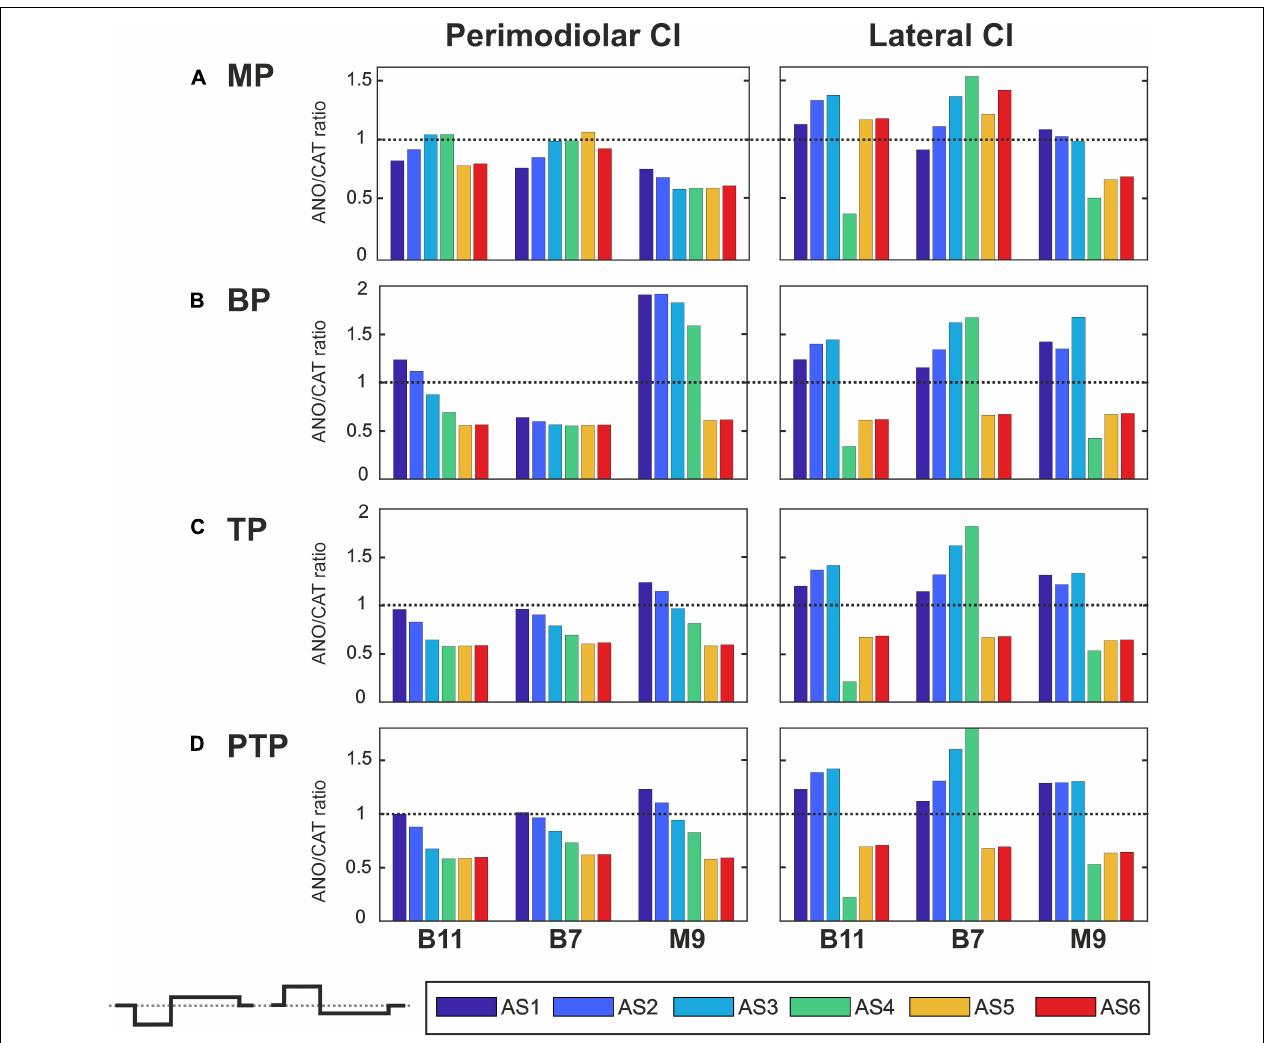
FIGURE 8 | Polarity ratios for different degeneration levels stimulated with the pseudomonophasic pulse. Layout as in Figure 7